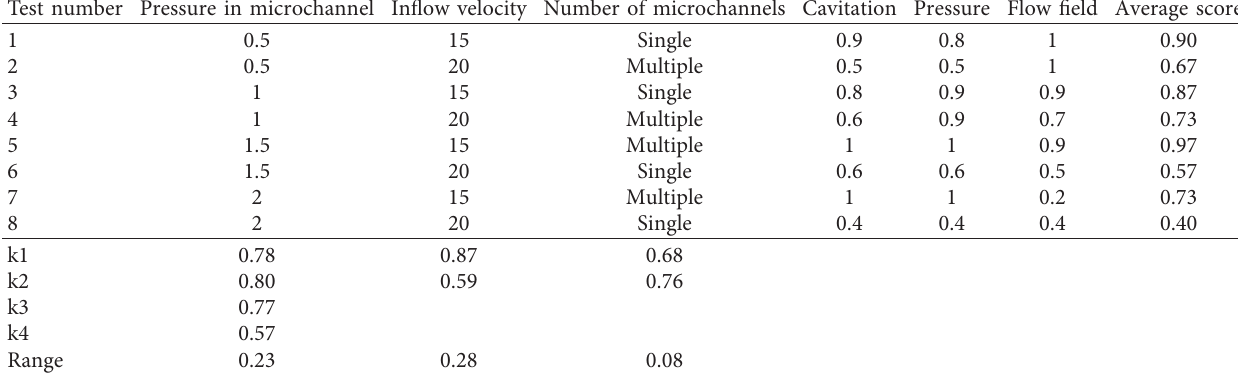
Table 3: Test results and visual analysis